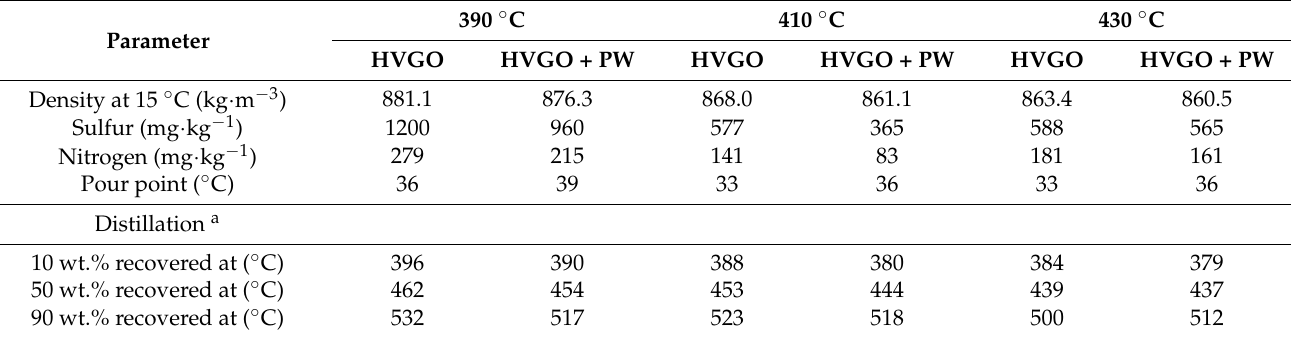
a data obtained from simulated